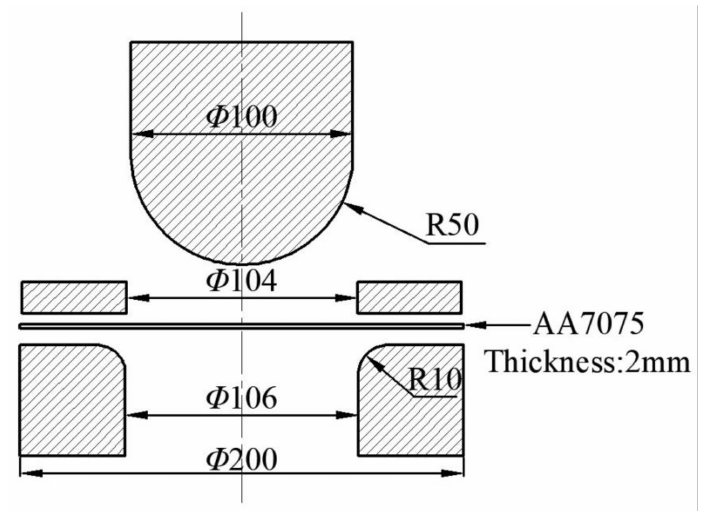
Figure 6. Dimensions of sheet metal forming test machine